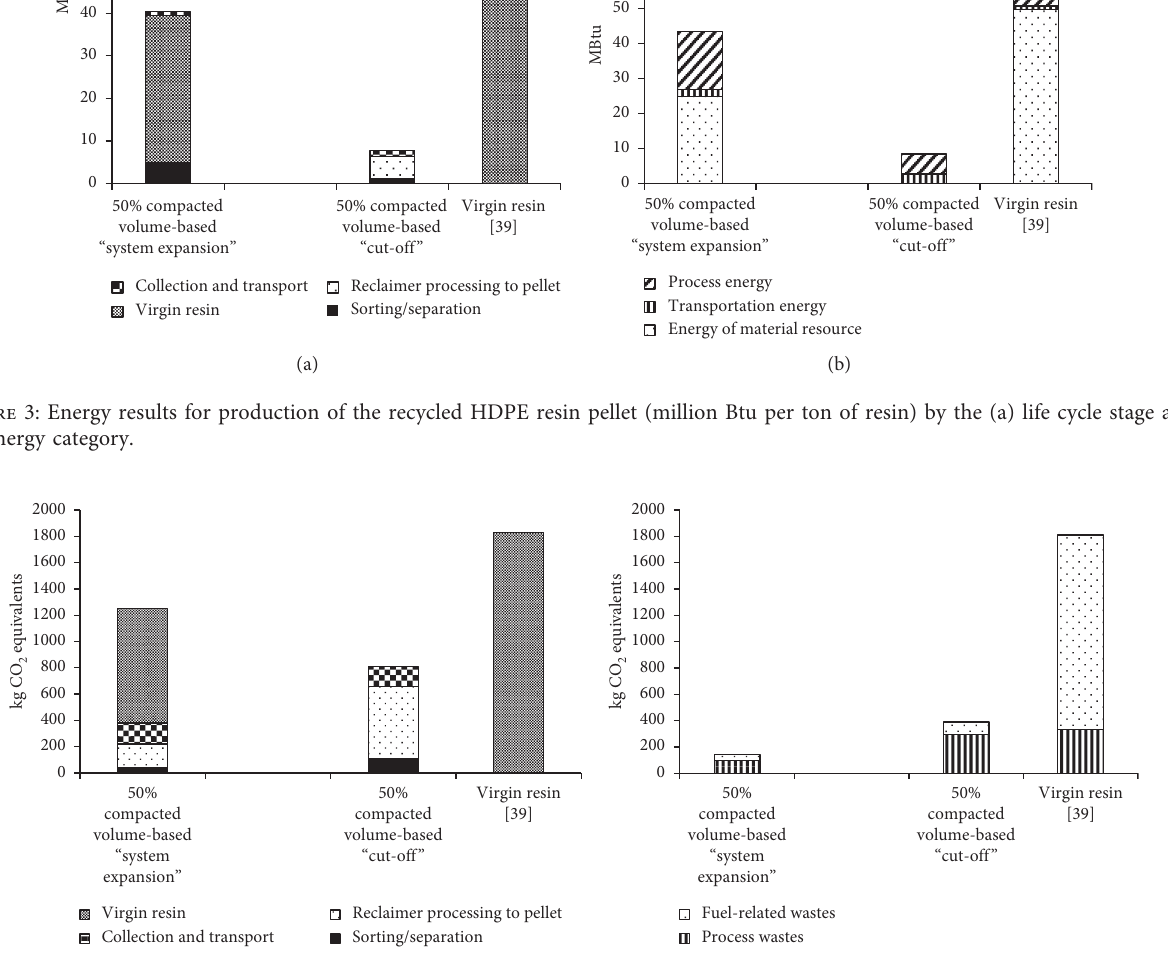
2 equivalents per ton of resin) by the (a) life cycle